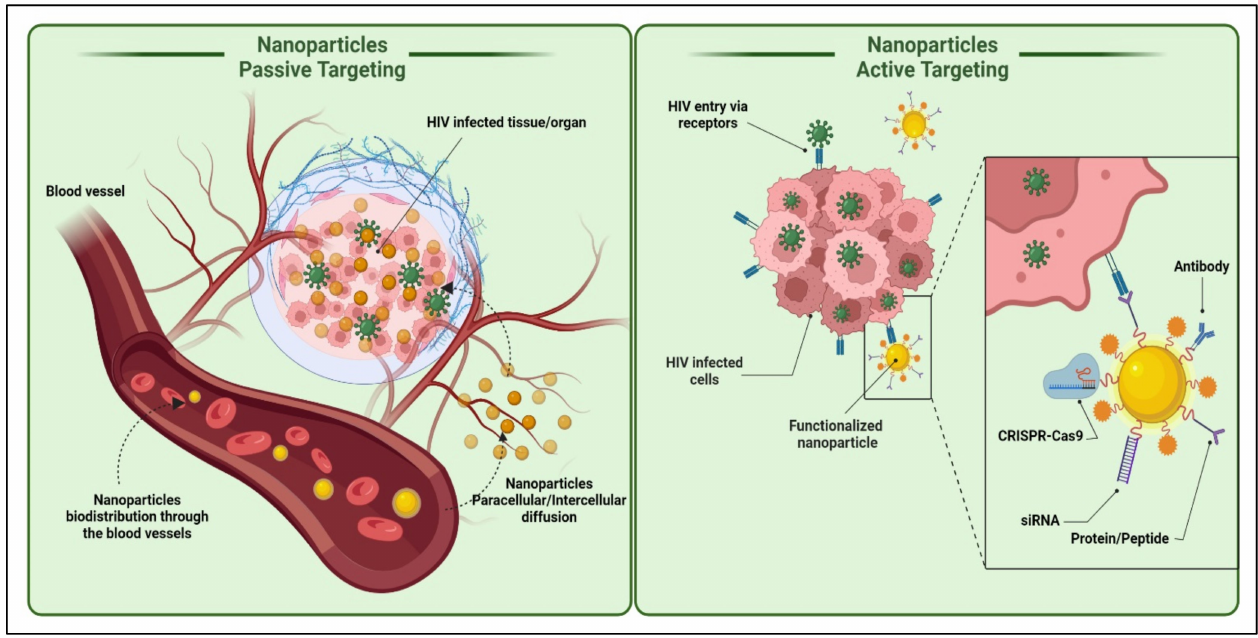
Figure 7. Schematic representation of nanocarrier internalization via various endocytosis mechanisms. (Created with BioRender.com (accessed on 19 June